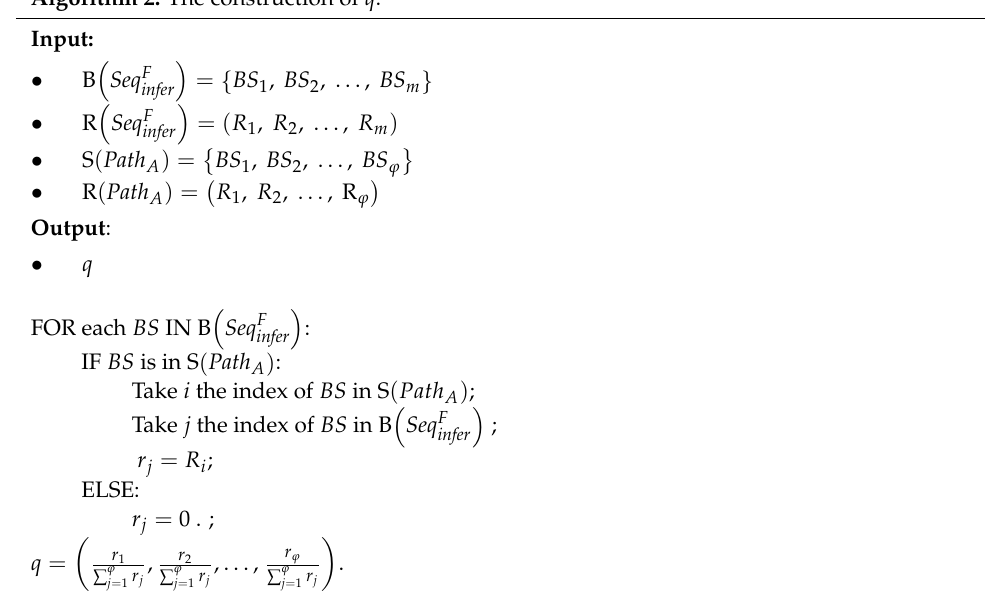
Algorithm 2. The construction of q